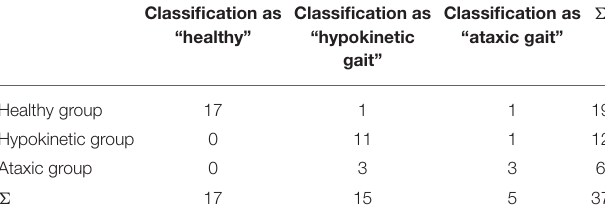
TABLE 3 | Contingency table for CNN classification in 3